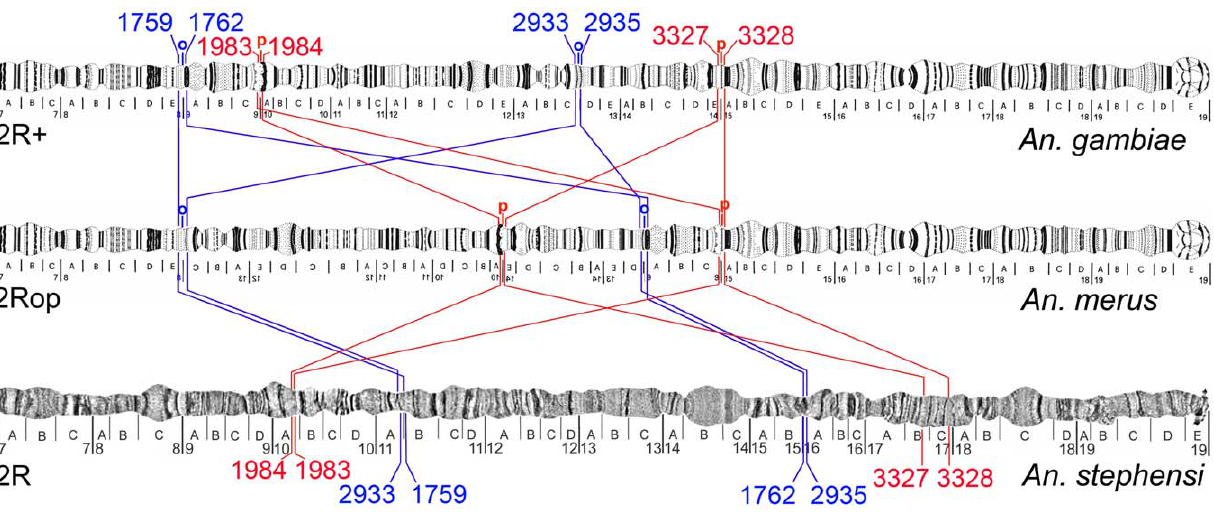
Figure 2. Gene orders in the polytene chromosomes at 2Ro/2R + o and 2Rp/2R + p breakpoints. Genes of ingroup species An. merus , An. gambiae , and outgroup species An. stephensi are shown on polytene chromosomes. Genes AGAP001759, AGAP001762, AGAP002933, and AGAP002933 of 2Ro/2R + o (in blue), and genes AGAP001983, AGAP001984, AGAP003327, and AGAP003328 of 2Rp/2R + p (in red) are indicated by their last four